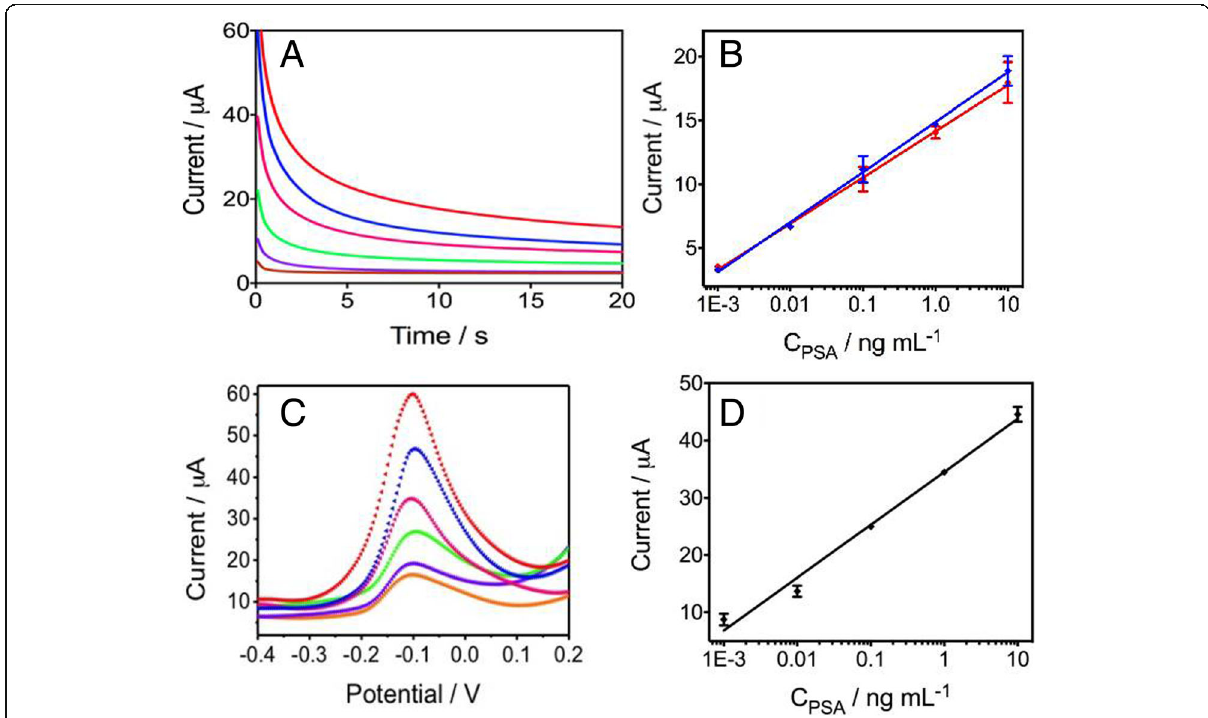
Fig. 5 a Chronoamperometric curves for various concentrations of PSA antigen (ascending along the y -axis): 0, 0.001, 0.01, 0.1, 1, and 10 ng/mL in pH 7.4 PBS buffer containing 4.5 mM hydroquinone and 0.1 mM H 2 O 2 solution in CASPE-MFD at − 2.0 mV vs silver pseudo-reference electrode. b The linear relationship between peak current and PSA antigen concentration in the CASPE-MFDs in pH 7.4 PBS buffer (blue line) and in human serum (red line). The linear regression equation of the blue line is Y = 14.87 + 3.927 × X ( R 2 = 0.9985, n = 8), and the linear regression equation of the red line is Y = 14.15 + 3.622× X ( R 2 = 0.9986, n = 8). c Square wave voltammograms for various concentrations of PSA antigen in pH 7.4 PBS buffer containing 4.5 mM hydroquinone and 0.1 mM H 2 O 2 solution in CASPE-MFD (ascending along the y -axis): 0, 0.001, 0.01, 0.1, 1, and 10 ng/ mL, respectively. d The corresponding linear relationship of different concentrations of PSA antigen. The linear regression equation is Y = 34.53 + 9.246 × X ( R 2 = 0.9884, n =